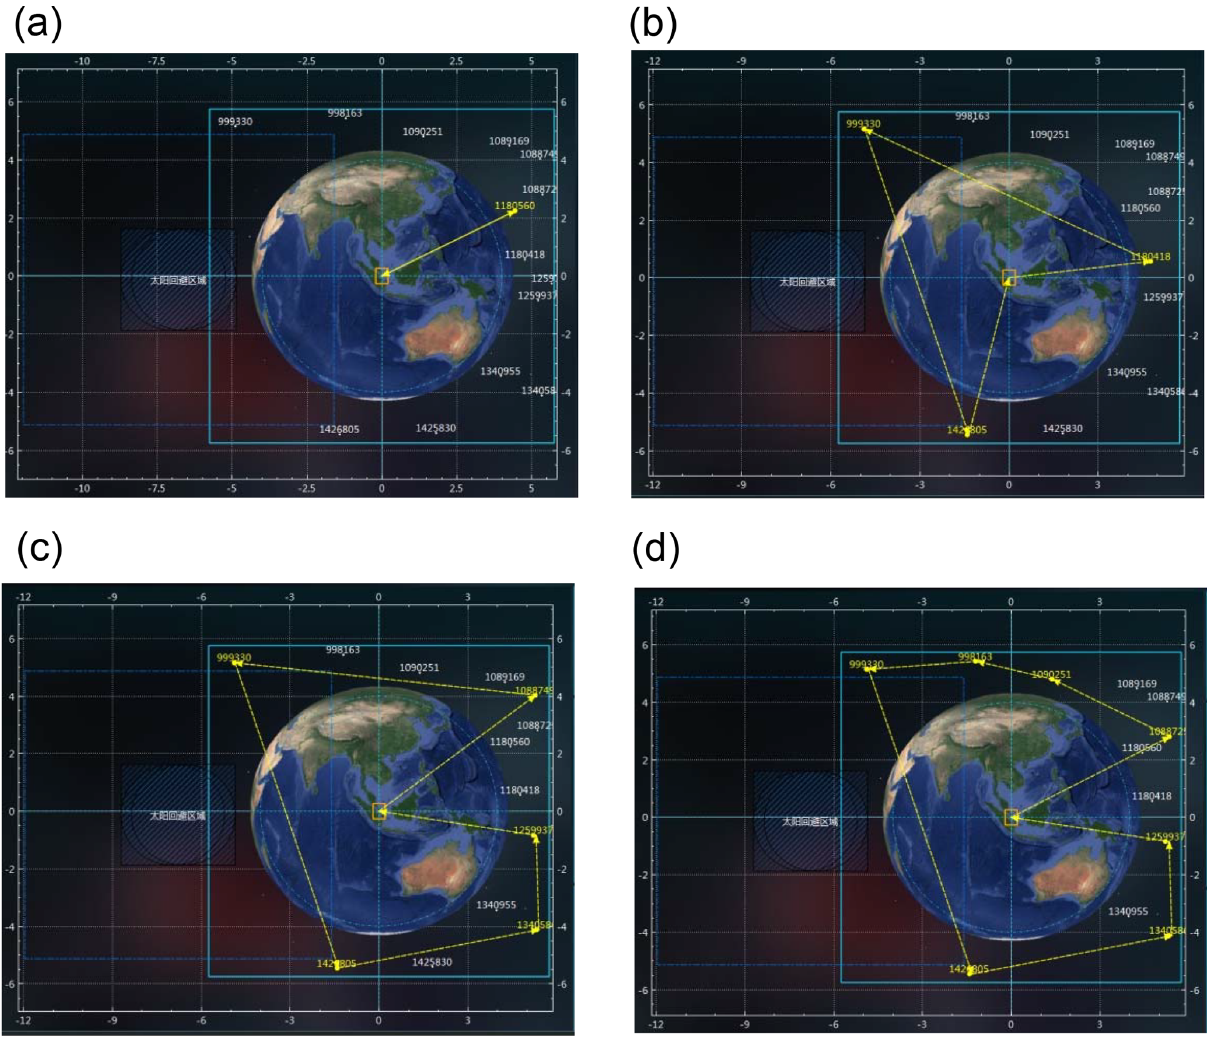
Figure 12. GIIRS star selection results – with the sun: (a) the result of choosing one star, (b) the result of choosing three stars, (c) the result of choosing five stars and (d) the result of choosing seven